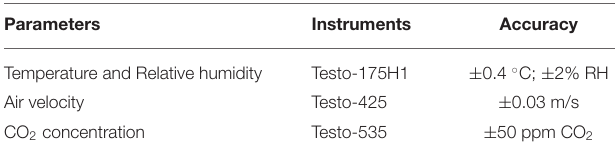
TABLE 8 | Instruments and accuracy.